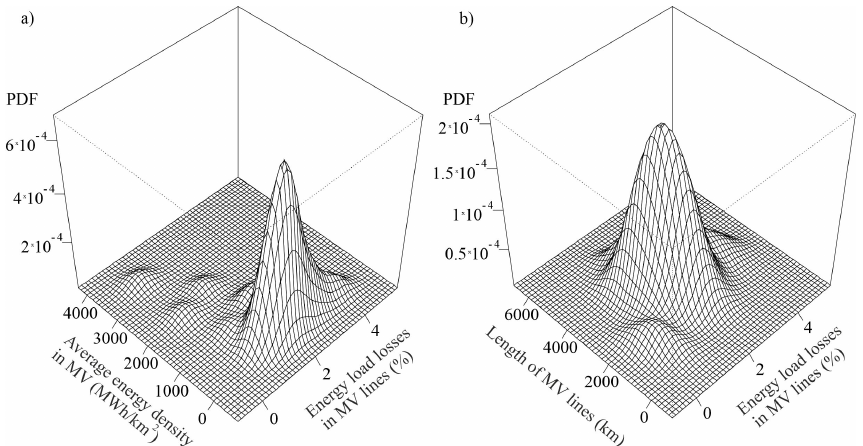
Figure 2. Two-dimensional density function obtained by means of KDE function for: ( a ) average energy density in MV and energy load losses in MV lines, ( b ) length of MV lines and energy load losses in MV.